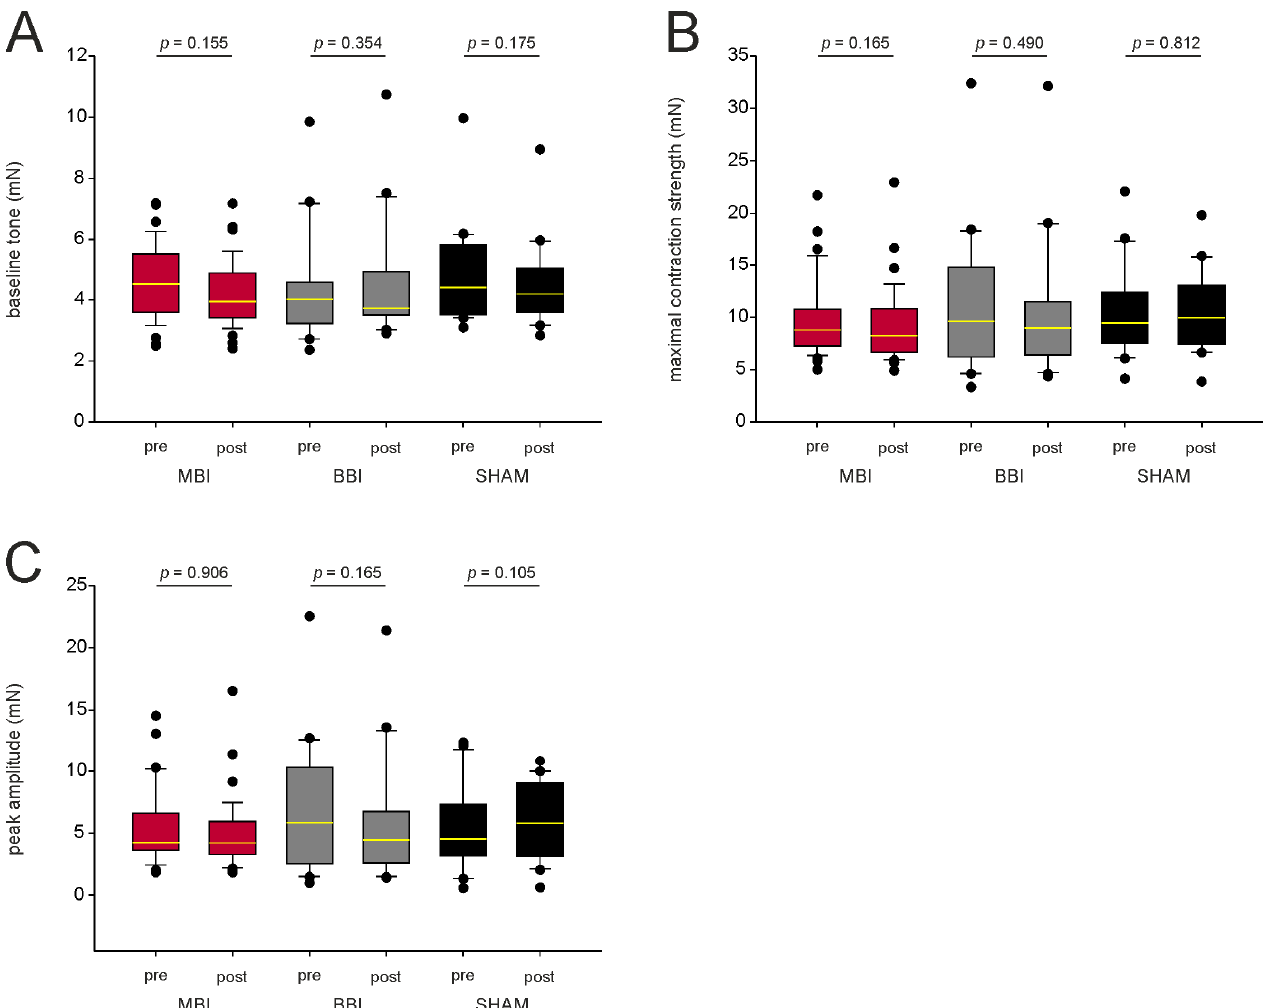
Figure 3. Characterization of the contractile apparatus. ( A , B , C ) CCH-induced contraction before and after irradiation for mean baseline tone, mean maximal contraction strength, and mean peak amplitude. There is no statistical difference before and after irradiation, indicating that MBI and BBI do not affect the contractile apparatus. P -values were calculated with a paired t -test, and, respectively, with a Wilcoxon test ( p > 0.05). Outliers are plotted as black dots. * p < 0.05; The median is illustrated by the yellow horizontal line. Abbreviations: MBI: microbeam irradiation (red boxplot); BBI: broadbeam irradiation (gray box-plot); SHAM: SHAM irradiation (black boxplot); pre-RT and post-RT: before (pre) and after (post) irradiation; CCH = carbachol. The number of segments is given in parentheses.